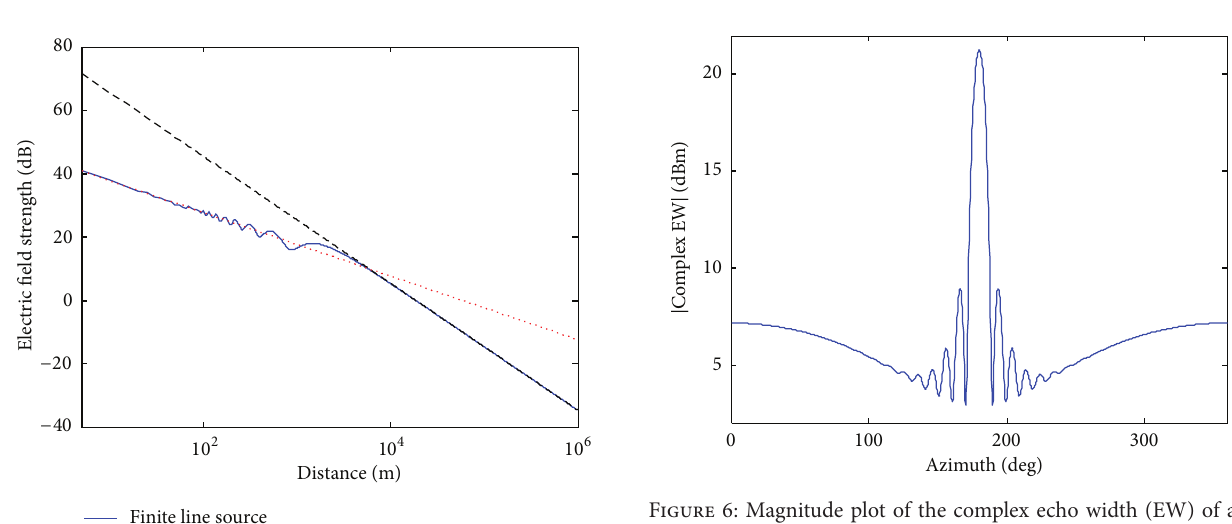
Figure 6: Magnitude plot of the complex echo width (EW) of an infinite 2D